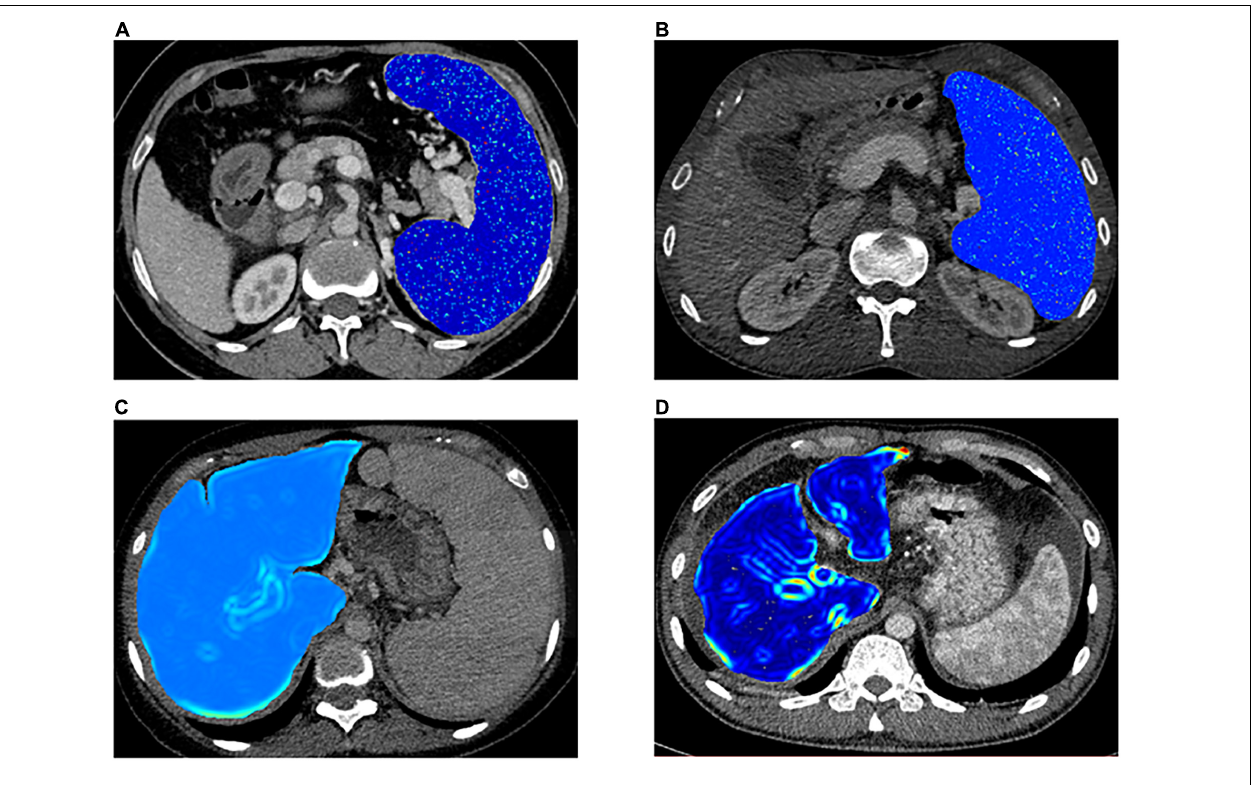
FIGURE 5 | Representative cases for stratifying portal hypertension (PH) and patients’ survival condition. (A,B) Visualized spleen-derived texture feature of wavelet.LLH_ngtdm_Busyness in high-risk PH patients [portal vein pressure (PVP) ≥ 20 mm Hg] and low-risk PH patients (PVP < 20 mm Hg) respectively. (C,D) Visualized liver-derived texture feature of log.sigma.3.0.mm.3D_firstorder_RobustMeanAbsoluteDeviation in the high-risk patients and low-risk patients,